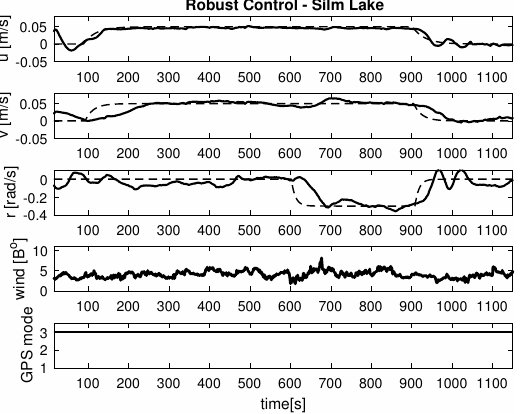
Figure 14. Trajectory ship ‘Blue Lady’ for ahead maneuver with longitudinal velocity u = 0.05 [m/s], v = 0.05 [m/s], r = − 0.3 [rad/s] wind [ B o ] and GPS mode [-], maneuver duration 1100 [s].